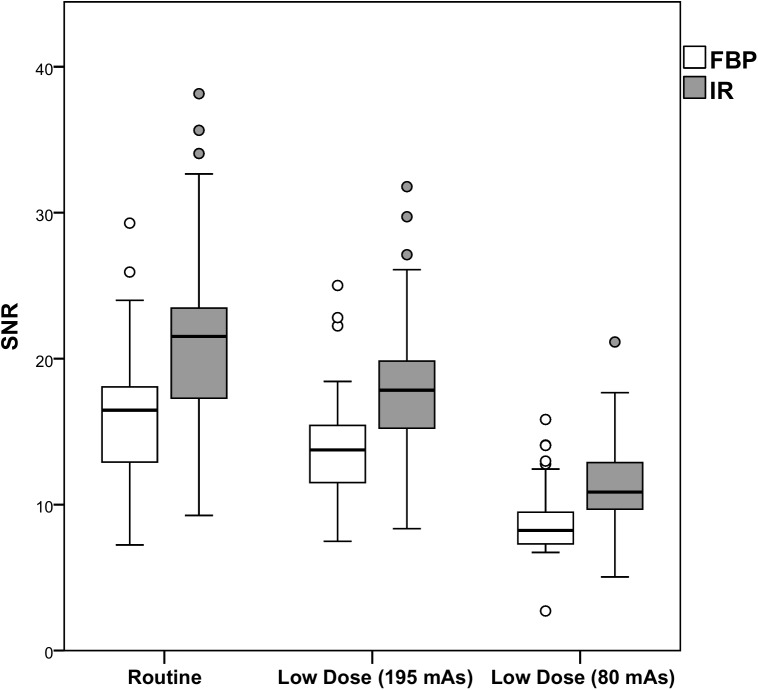
SNR per dose level for FBP and IR.The white boxes represent the SNR with FBP, while the gray boxes represent the SNR with IR. IR resulted in an increase in SNR compared to FBP at the same dose level. FBP Filtered Back Projection, IR Iterative Reconstruction, SNR Signal-to-noise ratio